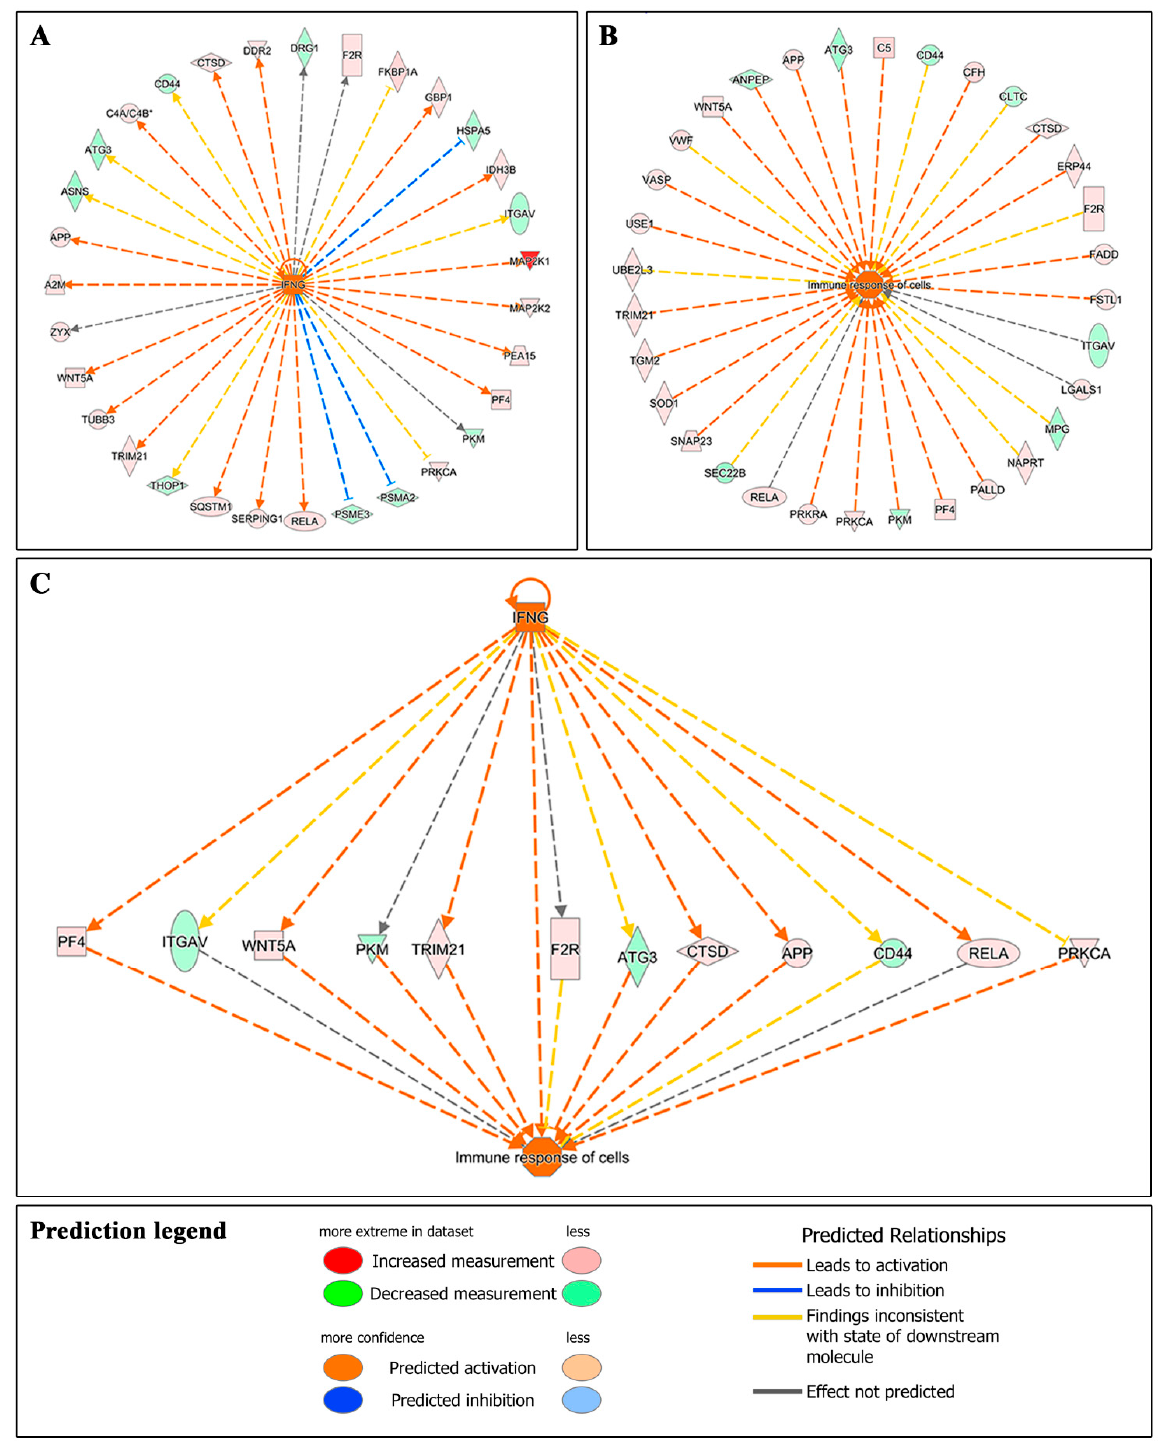
Figure 4. IPA analysis of differentially expressed proteins related to an immune response. ( A ) the IPA upstream regulators analysis suggests that several proteins differentially expressed with AS treatment are related to the activation of HK by IFN- γ . ( B ) IPA downstream analysis also showed that numerous differentially expressed proteins are associated with an immune response of HK cells treated with undiluted AS. ( C ) Finally, IPA upstream/downstream analysis link some differentially expressed proteins with the activation of HK cells by IFN- γ and the induction of an immune response.